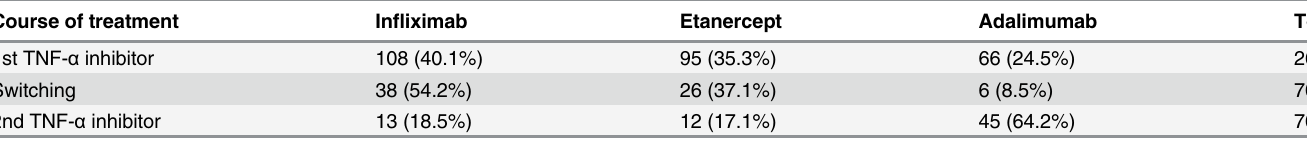
Table 1. Number of patients according to the course of